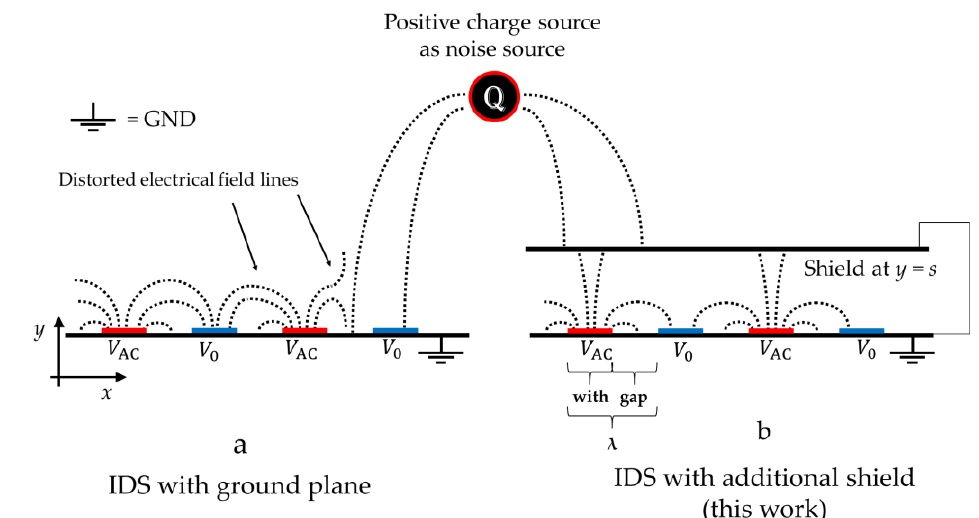
Figure 1. Working principle of a grounded shield. The arbitrarily positive source charge as noise source emanates an electric field which interacts with the IDS on the left hand side ( a ) whereas the shielded right hand side remains undisturbed from the external noise ( b ).